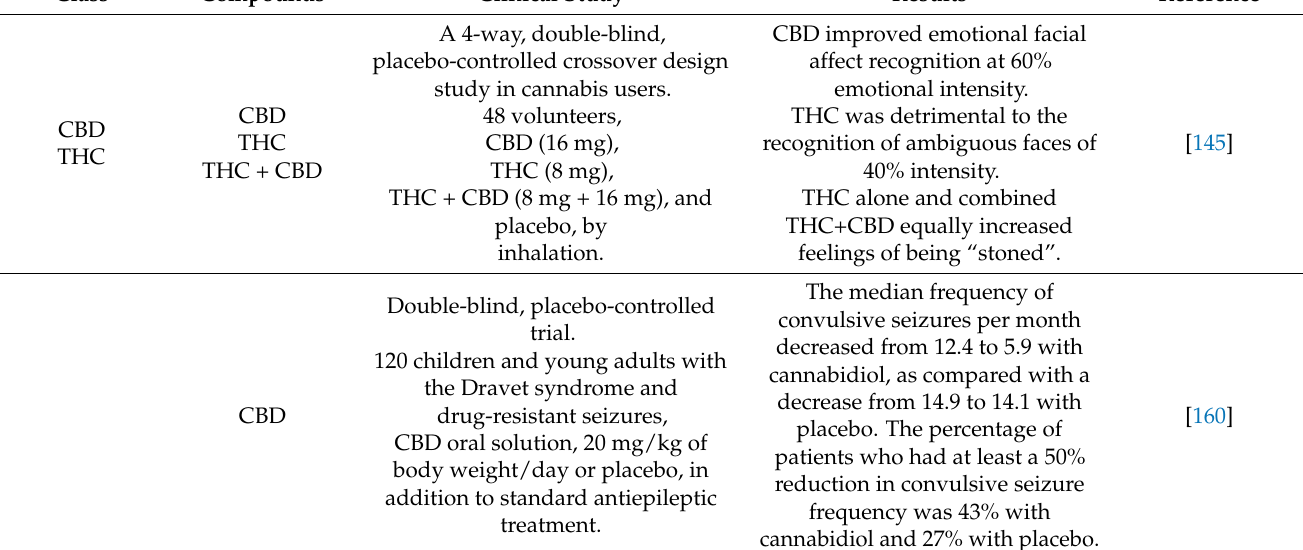
Table 4. The most important findings in clinical studies on major cannabinoids and their related compounds. Class